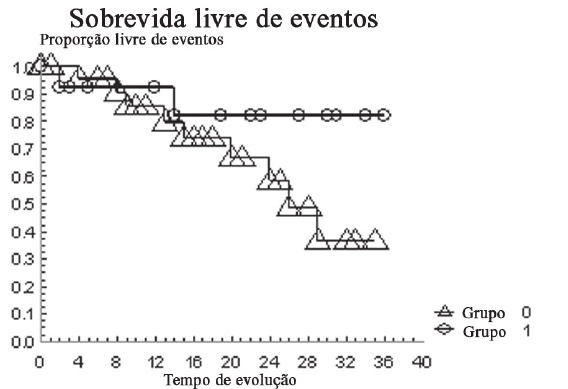
Fig. 1 - Curva Kaplan-Meier para eventos